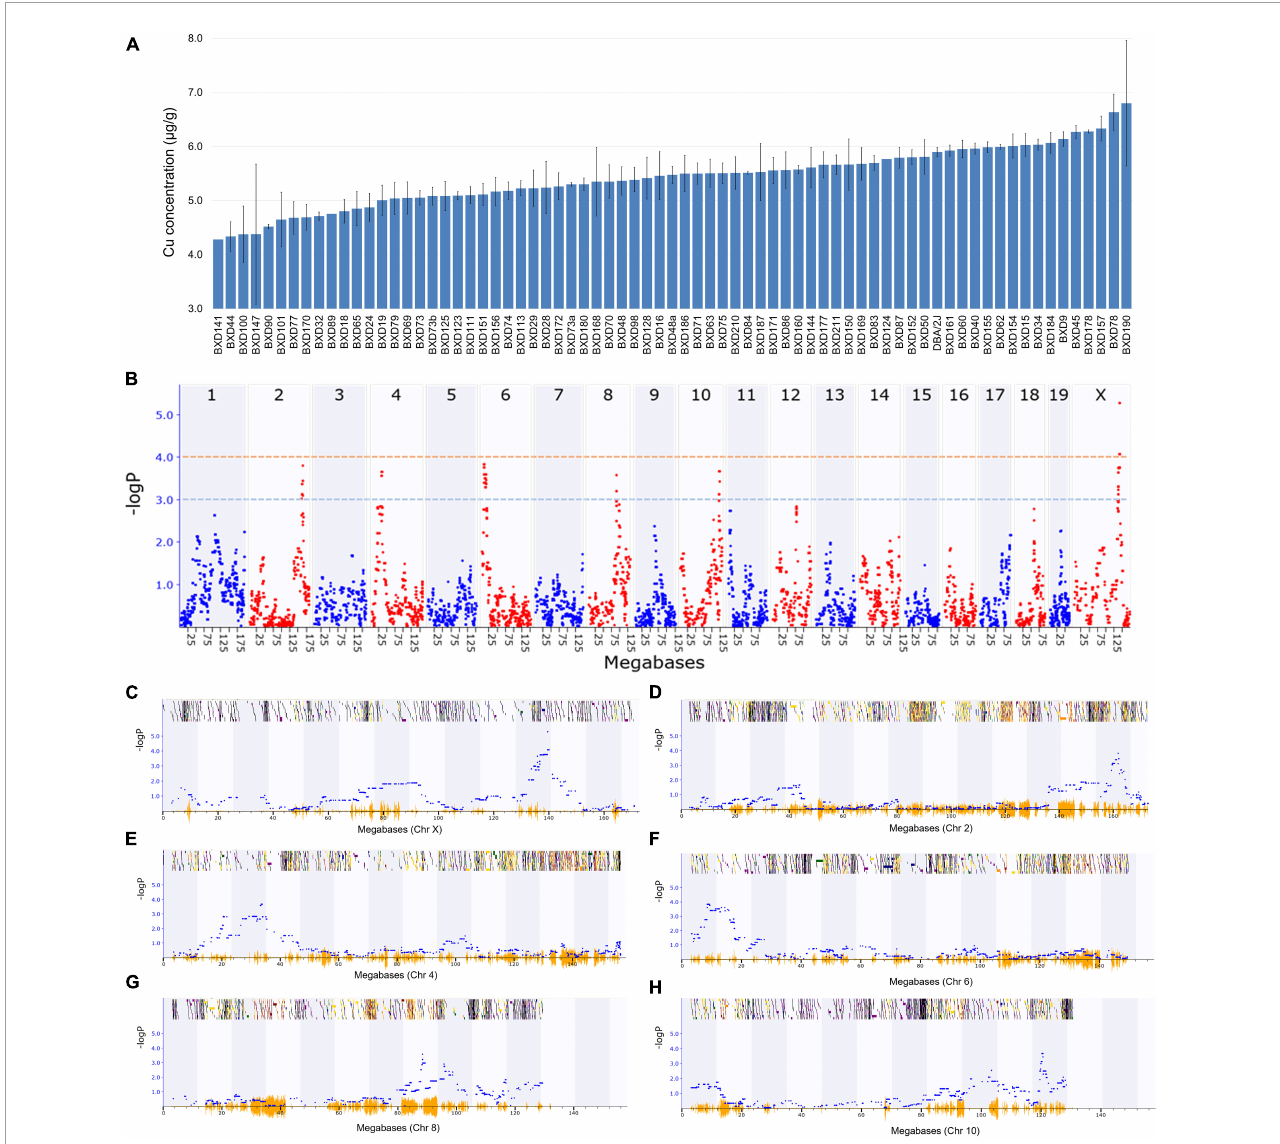
FIGURE1 Genetic mapping of the cardiac copper (Cu) concentration in BXD family mice. (A) Bar plot showing Cu concentration in the myocardium of BXD mice. The x-axis shows the BXD and the parental strains, and the y-axis shows Cu levels in µ g/g. (B) Manhattan plot indicating the genomic loci correlated with Cu concentration across all mouse chromosomes. The x-axis indicates the genomic position, while the y-axis shows the –log(P), a measurement of the linkage between Cu level and genomic region. The blue and red dotted lines indicate suggestive (–logP of 3) and significant (–logP of 4) genome-wide thresholds, respectively. (C–H) Genomic loci correlated with Cu concentration either with a significant or suggestive threshold in specific chromosomes. The x-axis indicates the genomic position, and y-axis denotes the –log(P)